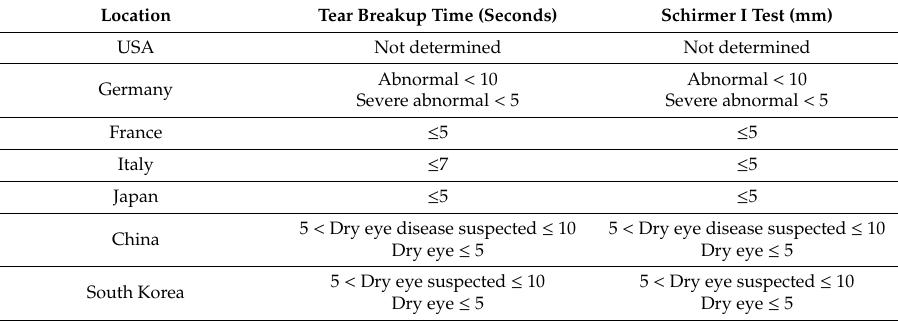
Table 3. Abnormal values of the tear breakup time and Schirmer I test in each